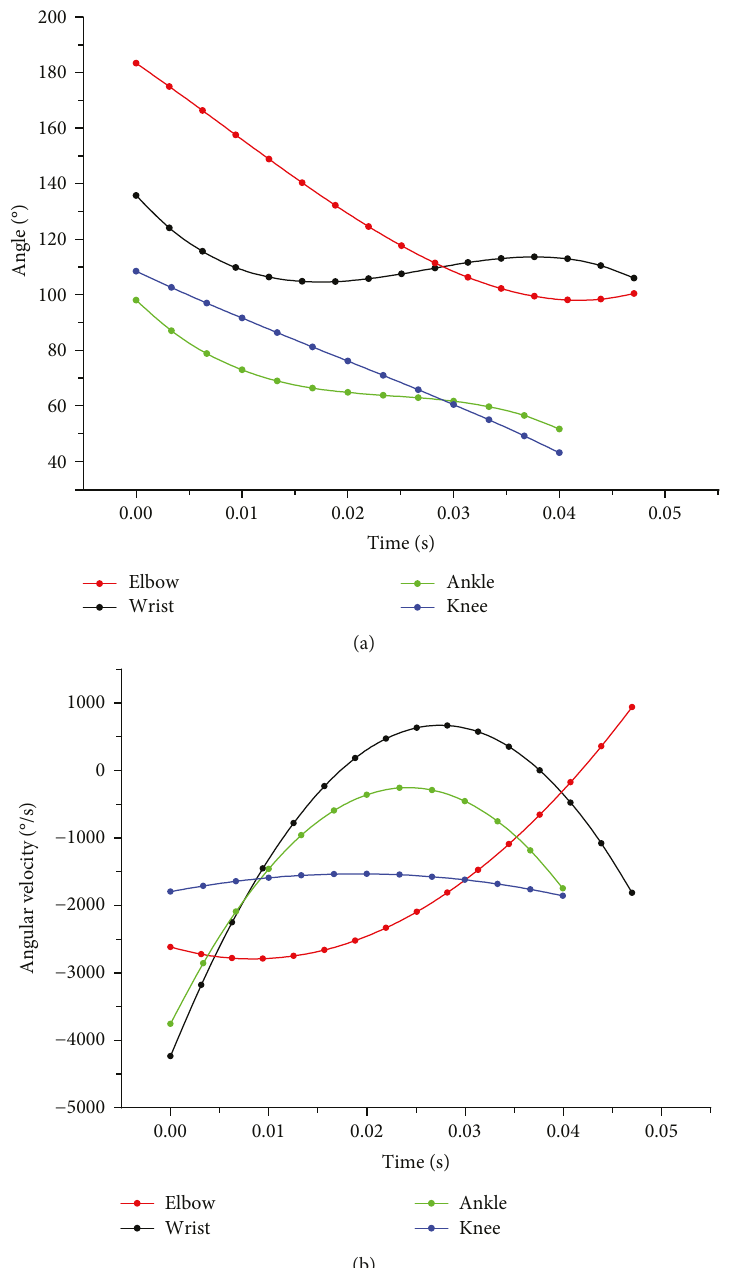
Figure 4: (a) Angles and (b) angular velocities of the wrist, elbow, ankle, and knee joints during landing from a 1.4m